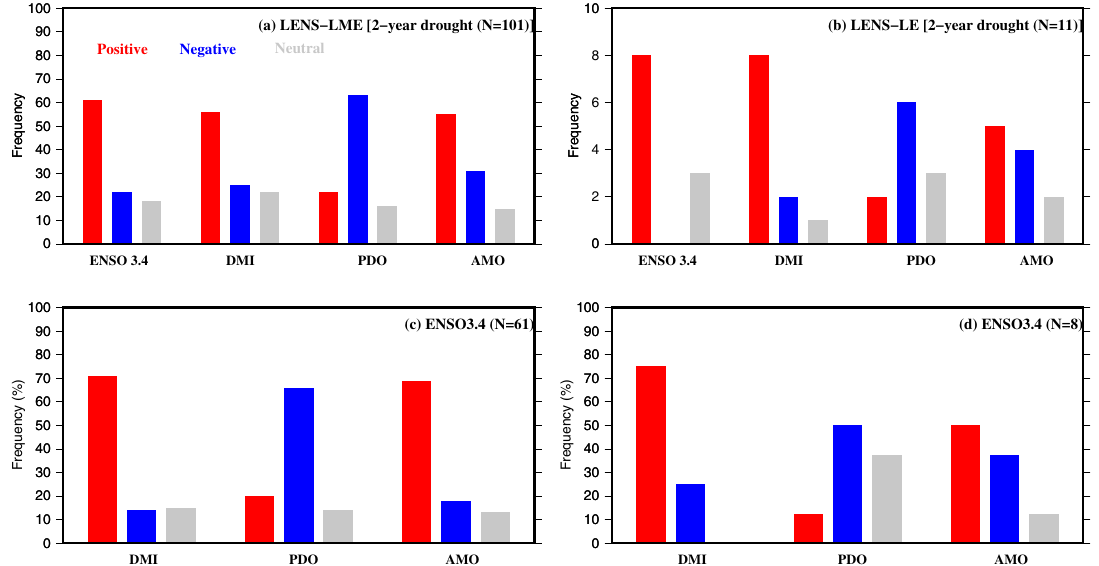
Fig. 6 The role of oceanic indices in historical and future megadroughts. a , b Megadrought frequency associated with ENSO3.4, DMI, PDO, and AMO during last millennium and future climate. c , d Co-occurrence of DMI, AMO, and PDO with ENSO3.4 associated megadroughts during last millennium and future climate, respectively. Positive and negative standardized anomalies of the oceanic indices were estimated using the threshold of 0.25 while neutral anomalies were considered if the values fell between − 0.25 and